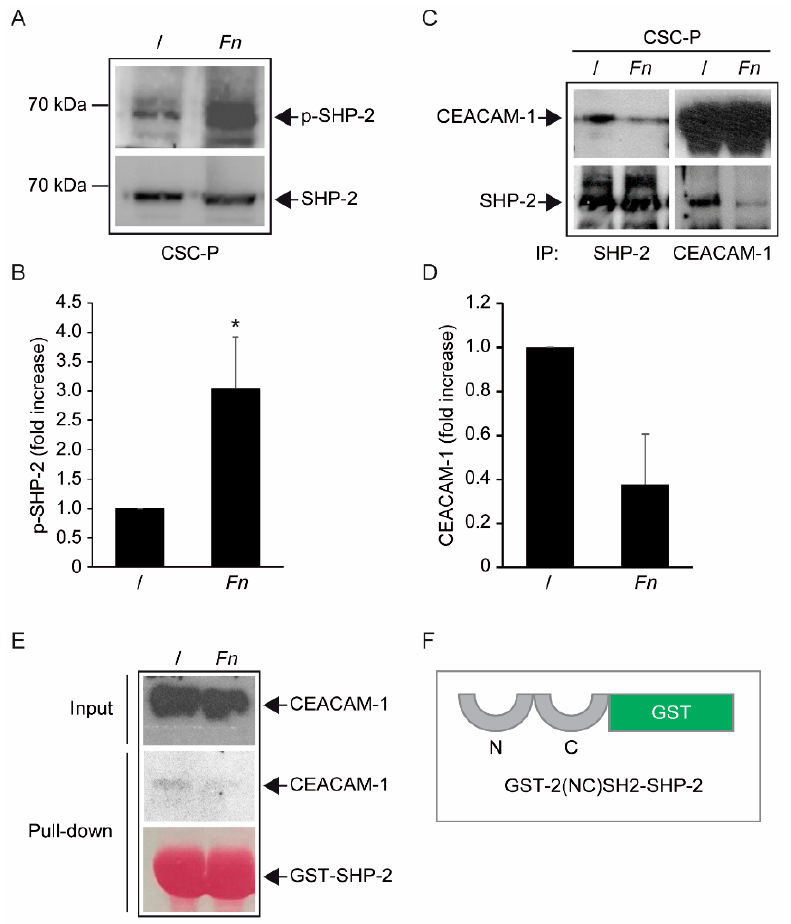
Figure 5. Effect of Fn on the CEACAM1-SHP2 complex in spheroidal cells. ( A ) Immunoblot detection of phospho-SHP-2 (Tyr542) and total SHP-2 in total cell lysates from Fn -treated (100 MOI for 20 min) CSC-P cells. Relevant bands around 70 kD are indicated by arrows. ( B ) Band densitometry for p(Tyr542)SHP-2 from n = 7 independent experiments. Values are the mean ± S.E.M. of stimulation indexes (stimulated/unstimulated). Statistics were determined by the Wilcoxon signed-rank test performed on raw data.(* p < 0.02). ( C ) CEACAM1/SHP-2 co-immunoprecipitation assay in CSC-P cells exposed to Fn as in ( A ). The abundance of the two proteins in anti-SHP2 immunoprecipitates (upper and lower left quadrants) and anti-CEACAM-1 immunoprecipitates (upper and lower right quadrants) was determined by standard immunoblotting. ( D ) CEACAM-1 relative abundance in anti-SHP-2 immunoprecipitates from Fn -stimulated compared with untreated cells over 3 inde- pendent experiments. The error bar is the SD. ( E ) Pull-down assay on protein lysates obtained as in ( A , C ). A GST fusion protein encompassing the 2 (N terminal and C-terminal) SHP2 phosphotyro- sine binding domains (depicted in panel ( F )) was used as bait. CEACAM-1 in input lysates (top) and GST-SHP2 precipitates (middle) was revealed by immunoblotting. Equal amounts of immobilized bait protein across different samples were confirmed by reversible Ponceau-S staining (bottom panel). 4. Discussion Intestinal bacteria have recently drawn unprecedented attention as a determinant of human health and disease; this is especially true for inflammatory bowel diseases and colorectal cancer as their most severe and worrisome complications. The proposed model whereby altered bacterial–host communication and the ensuing inflammatory response leads to un-resolving epithelial damage–regeneration cycles, eventually conducive to ma- lignant transformation and carcinogenesis, implies a primary involvement of intestinal stem cells in the process; however, our understanding of whether and how stem cells, and particularly CSCs, communicate with the microbiota is still incomplete [16]. The present work preliminarily addresses this critical knowledge gap by investigating the interaction